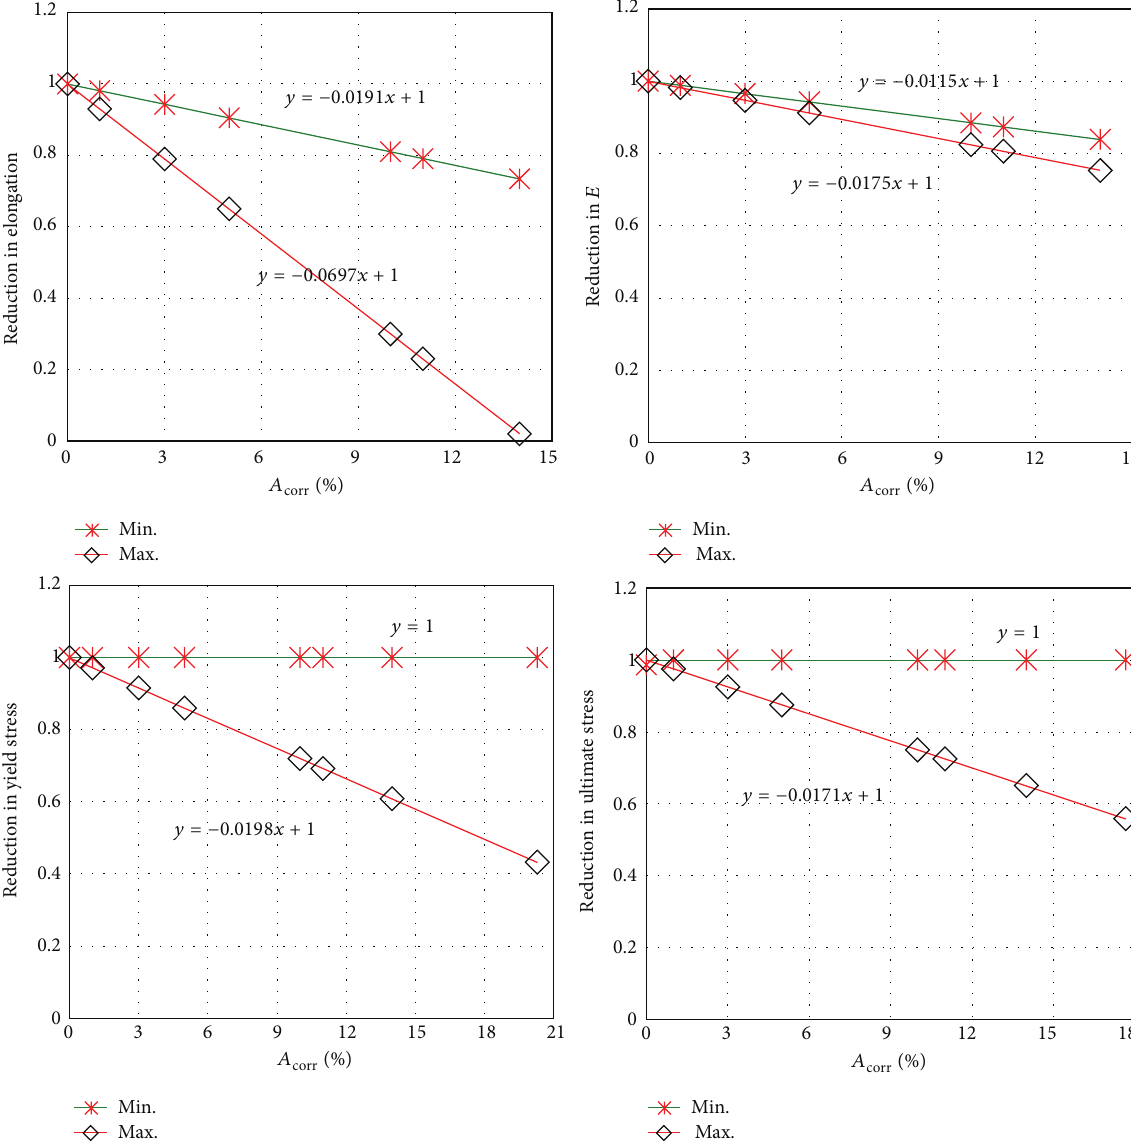
cycles required for rupture, respectively. Apostolopoulos